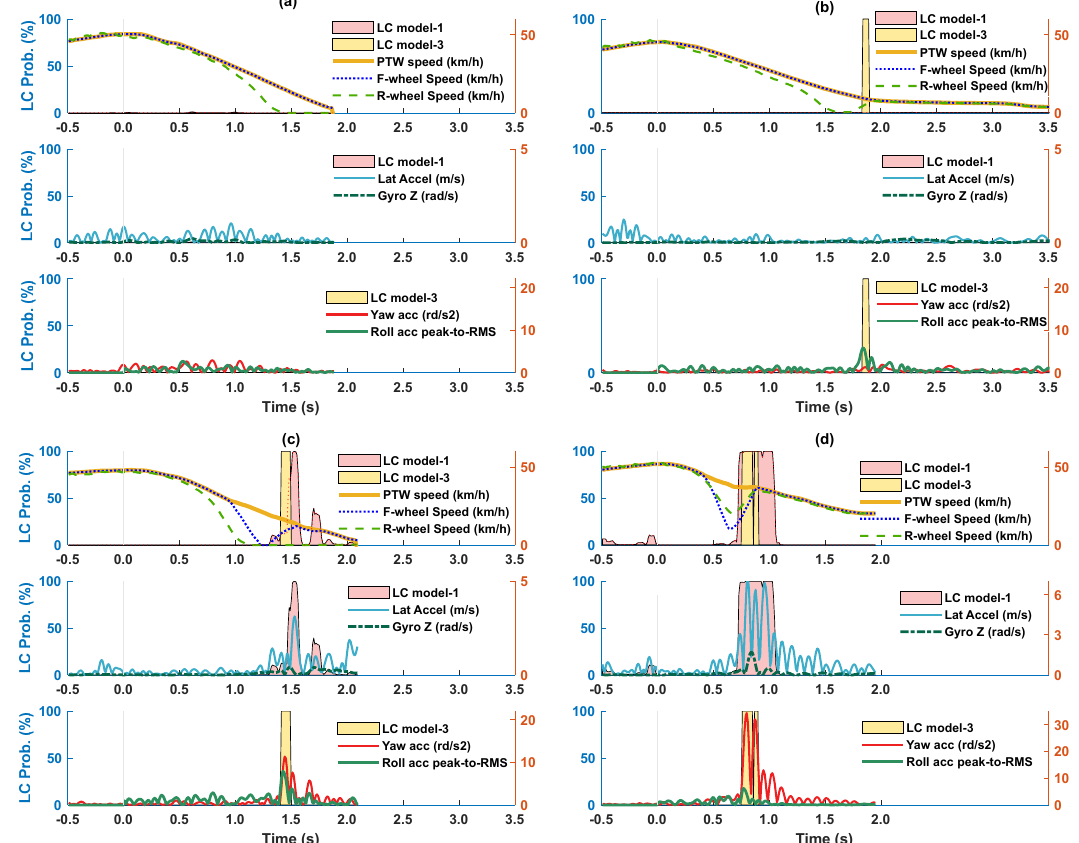
Figure 11. ( a ) full control braking trial with 0% of LC probability for Model-1 and Model-3; ( b ) loss of control detected only by Model-3 (LC probability for Model-1 = 0%); ( c ) loss of control detected earlier by Model-3; ( d ) loss of control detected earlier by